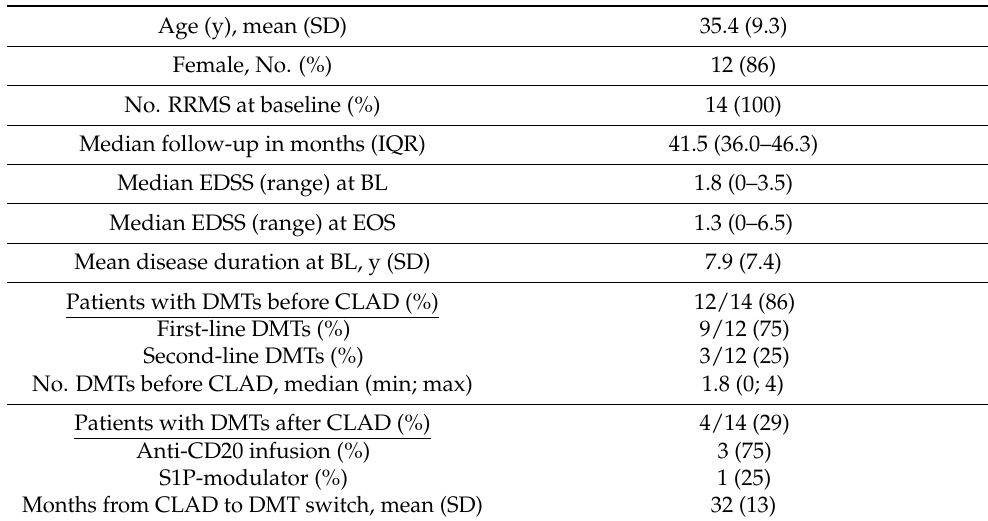
Table 1. Characteristics of patients included ( n =